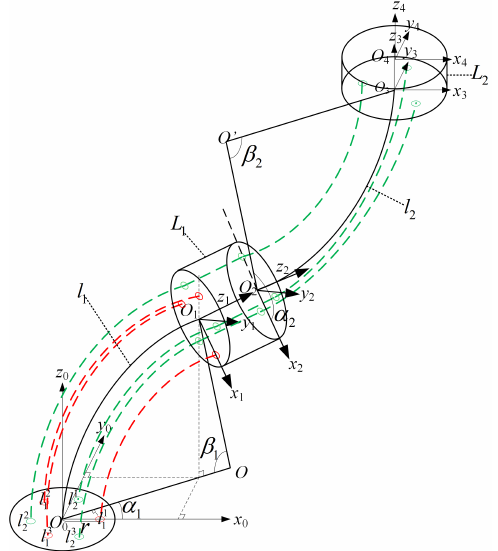
Figure 4. The geometric model of the two-segment flexible